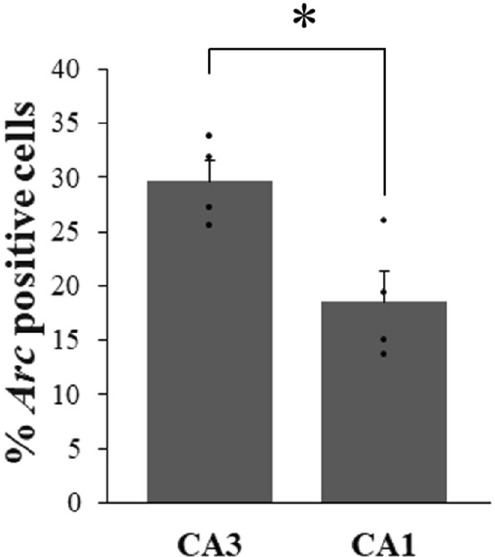
Figure 7. Percentage of Arc positive cells in CA3 and CA1 hippocampal subfields in HIP intact rats performing the memory task (means ± SEM). In addition to LEC and PER, CA3 and CA1 are highly recruited during memory retrieval in rats with intact hippocampus that rely on recollection and familiarity to solve this task (comparisons to 0: p < 0.01; CA3 more than CA1: *p < 0.05).